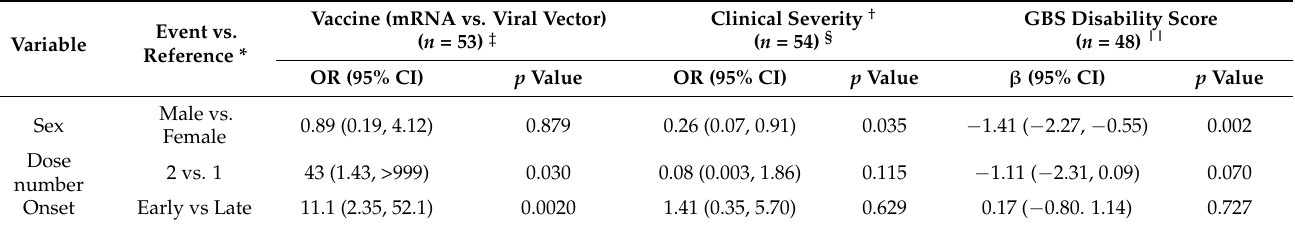
Table 2. Summary of multivariable regression